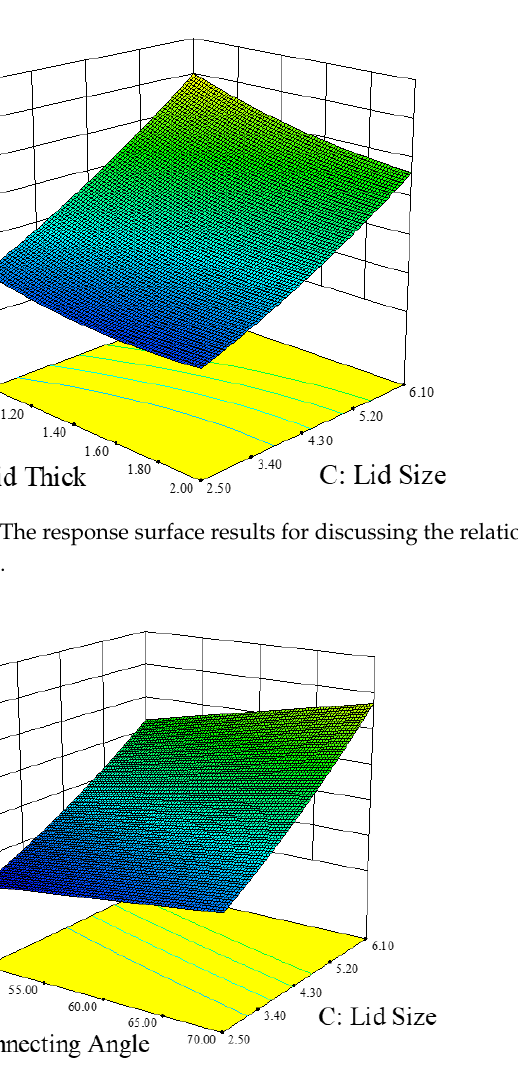
Figure 15. The response surface results for discussing the relationship between the connecting angle and the lid size.